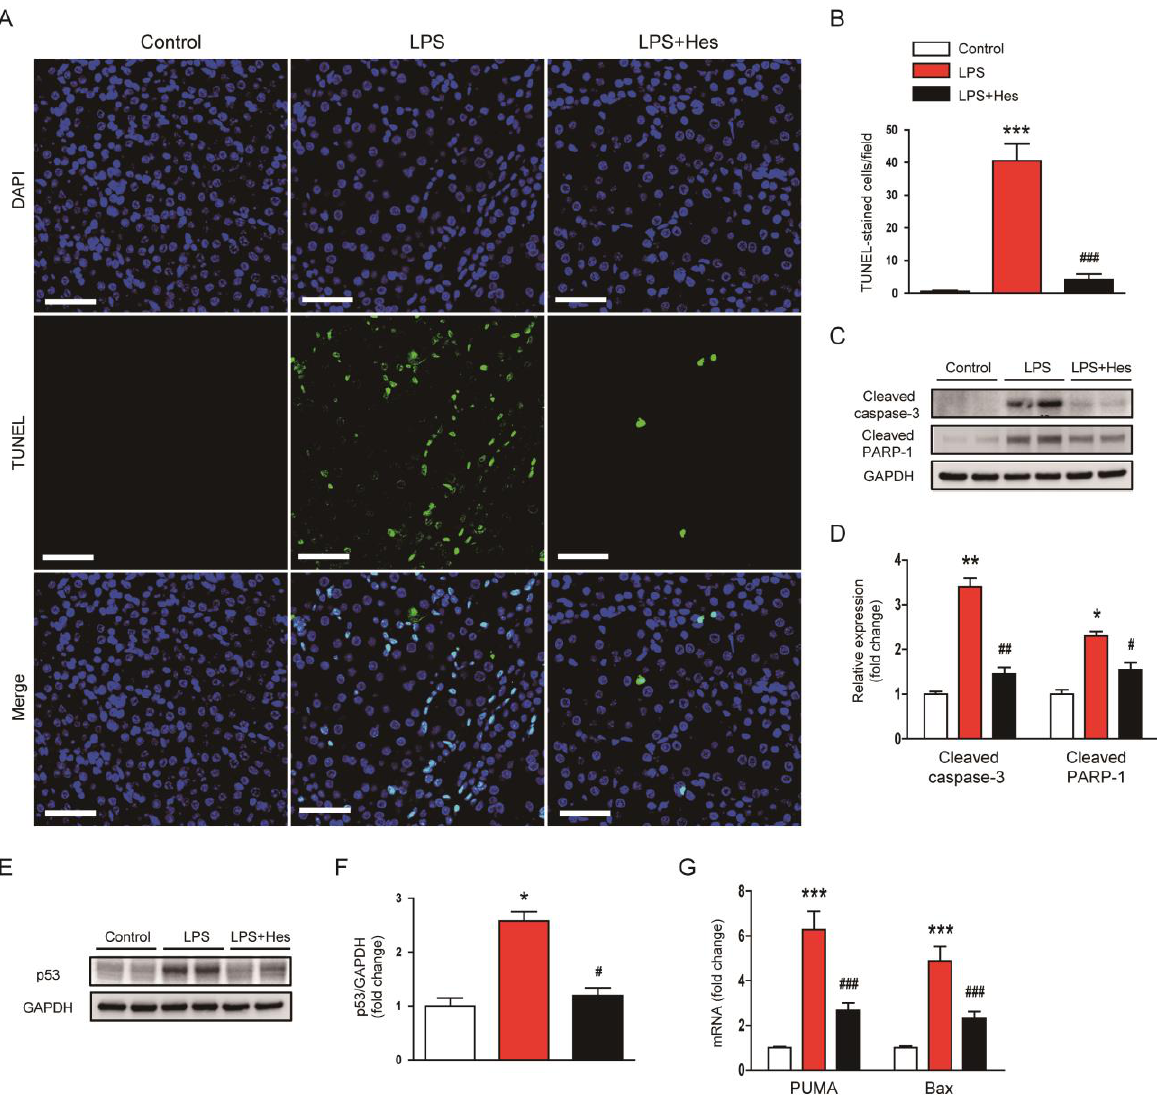
Figure 6. Hesperetin alleviated apoptotic cell death in LPS-injected mice. ( A ) TdT-mediated dUTP nick end labeling (TUNEL) staining (green). Nuclei were stained with DAPI (blue). Scale bar: 50 µ m. ( B ) Number of TUNEL-positive cells per field. ( C ) Western blotting of cleaved caspase-3 and cleaved poly(ADP-ribose) polymerase-1 (PARP-1). ( D ) Densitometric analysis of bands in ( C ). ( E ) Western blotting of p53. ( F ) Densitometric analysis of bands in ( E ). ( G ) Renal mRNA expression of p53 upregulated modulator of apoptosis (PUMA) and Bax. n = 8 per group. * p < 0.05, ** p < 0.01 and *** p < 0.001 vs. Control. # p < 0.05, ## p < 0.01 and ### p < 0.001 vs. LPS.